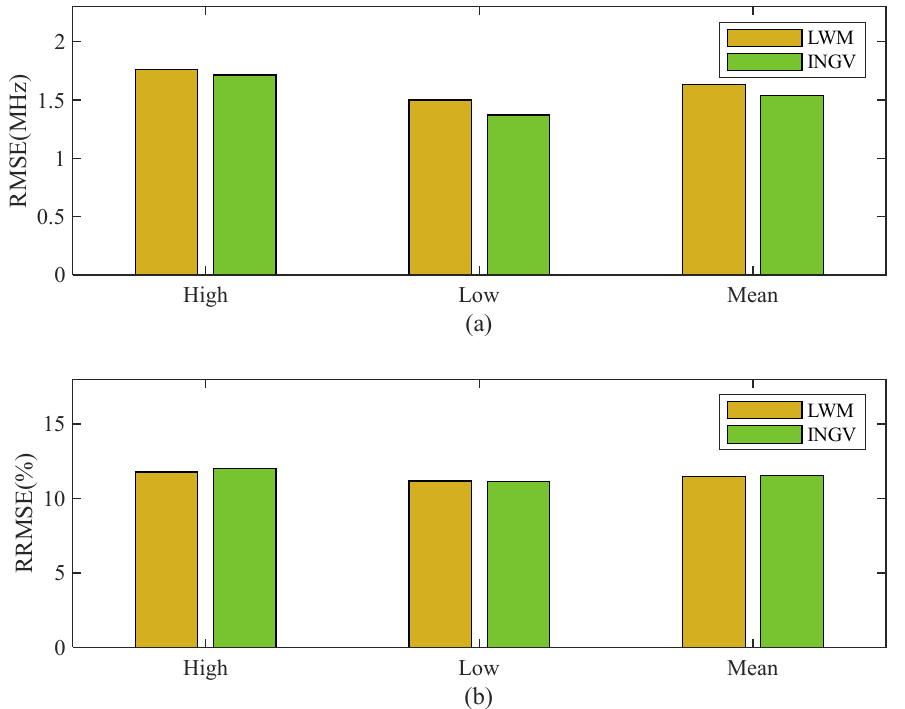
Figure 7. Comparison of MUFs predicted by the LWM and INGV during the relatively low and high solar activity epochs: ( a ) RMSE; ( b )RRMSE.